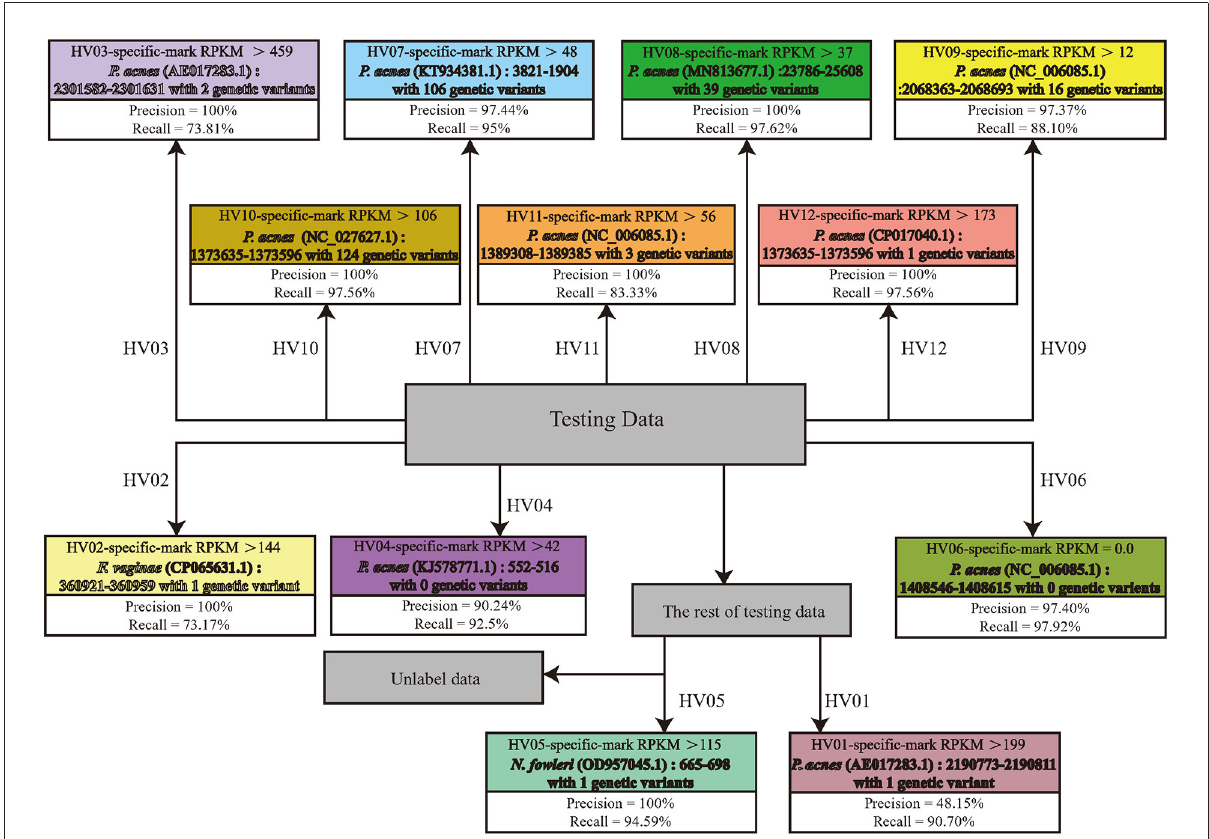
FIGURE10 The graph shows the result of using microbial fingerprints as features to classify individuals with a decision tree. The dark gray node in the center of the decision tree is the root node, representing all unlabeled samples. The other colored leaf nodes represent all